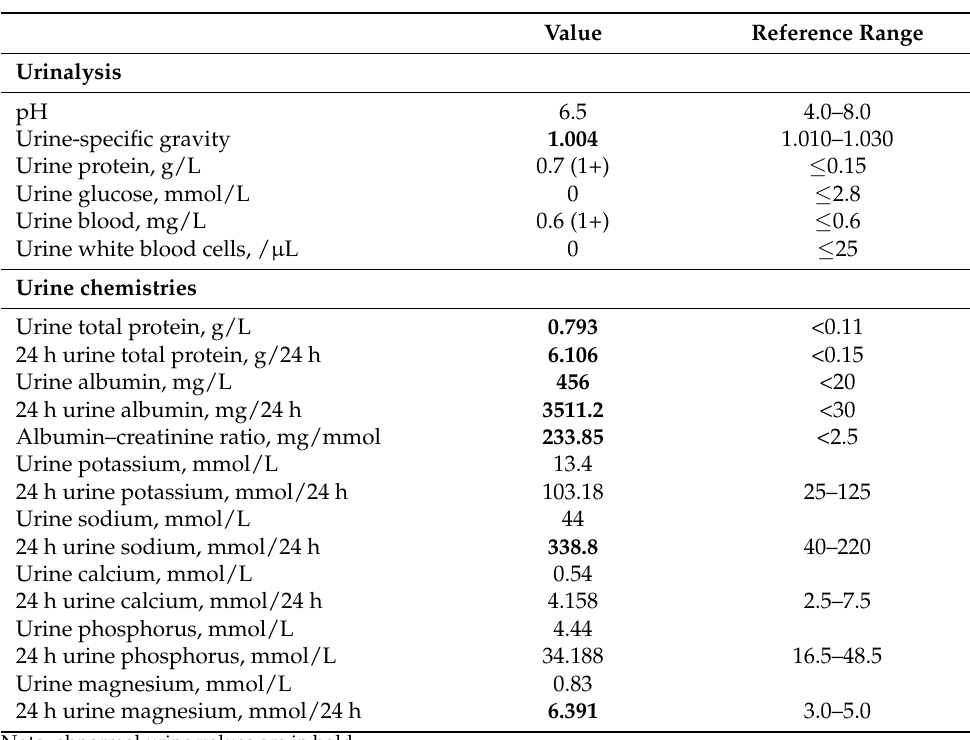
Table 2. Urinary analites.